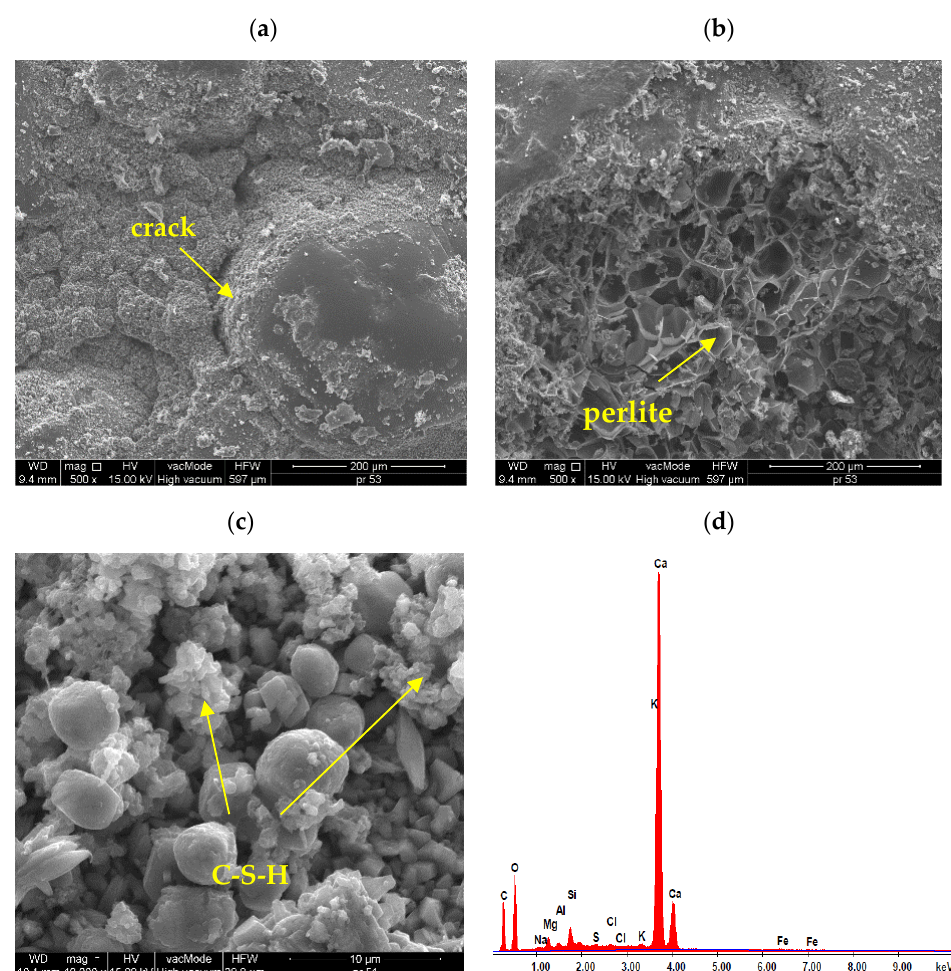
Figure 8. Micro-structure of standard lightweight mortars with perlite: ( a ) grain of sand surrounded by cement paste ( × 500), ( b ) combination of perlite with cement paste, intense interface between them ( × 500), ( c ) micro-area well-developed C-S-H phase crystals ( × 10 4 ), ( d ) results of elemental analysis in Energy Dispersive Spectroscopy (EDS) micro-area from the surface of standard samples.